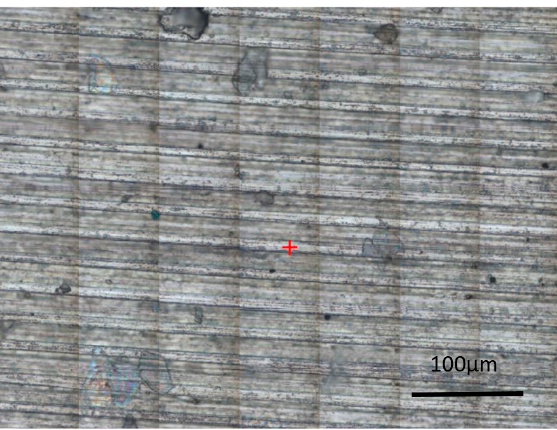
Figure 12. Optical image of the original structure area.